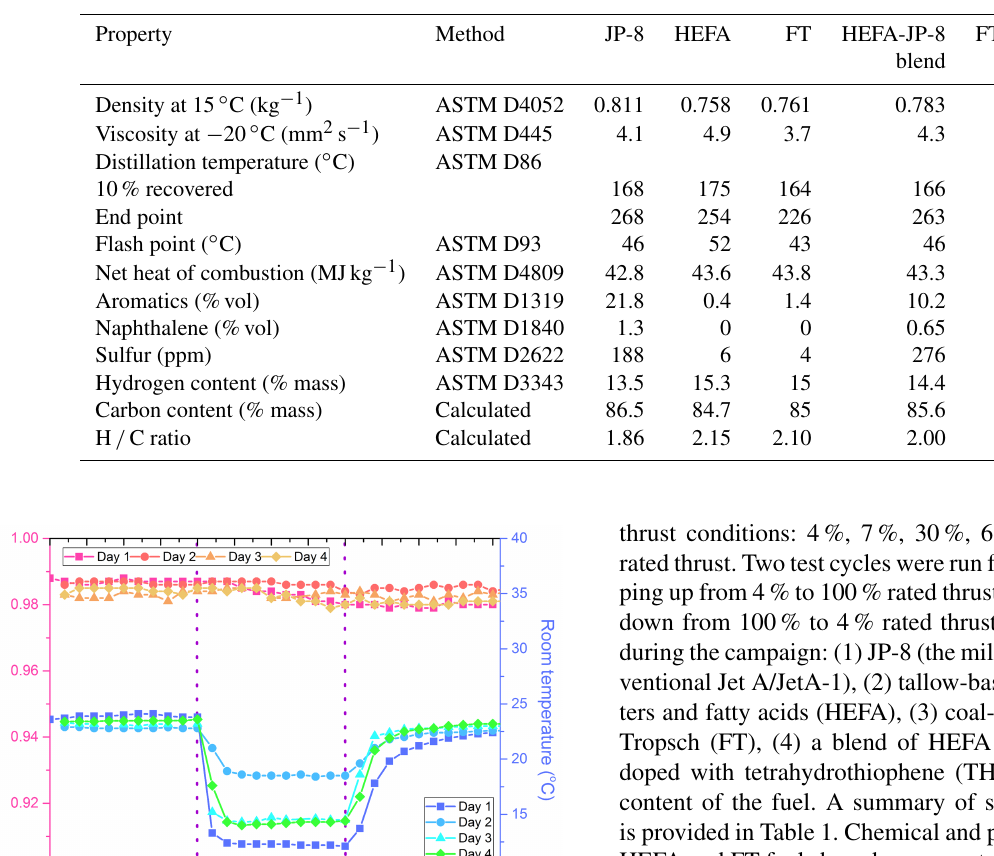
Table 1. Selected fuel properties.